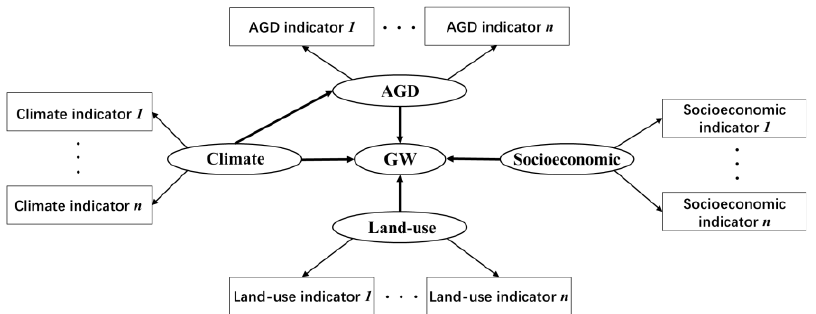
Figure 1. Conceptual scheme of the proposed SEM model for exploring the direct and indirect effects on groundwater (GW) of climate variability, socioeconomic development, agricultural water demand (AGD), and land-use.